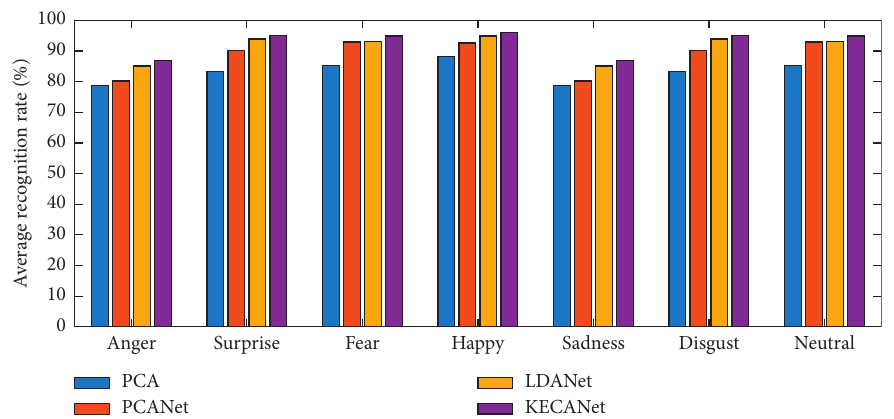
Figure 12: Comparing the test accuracies on the CK+